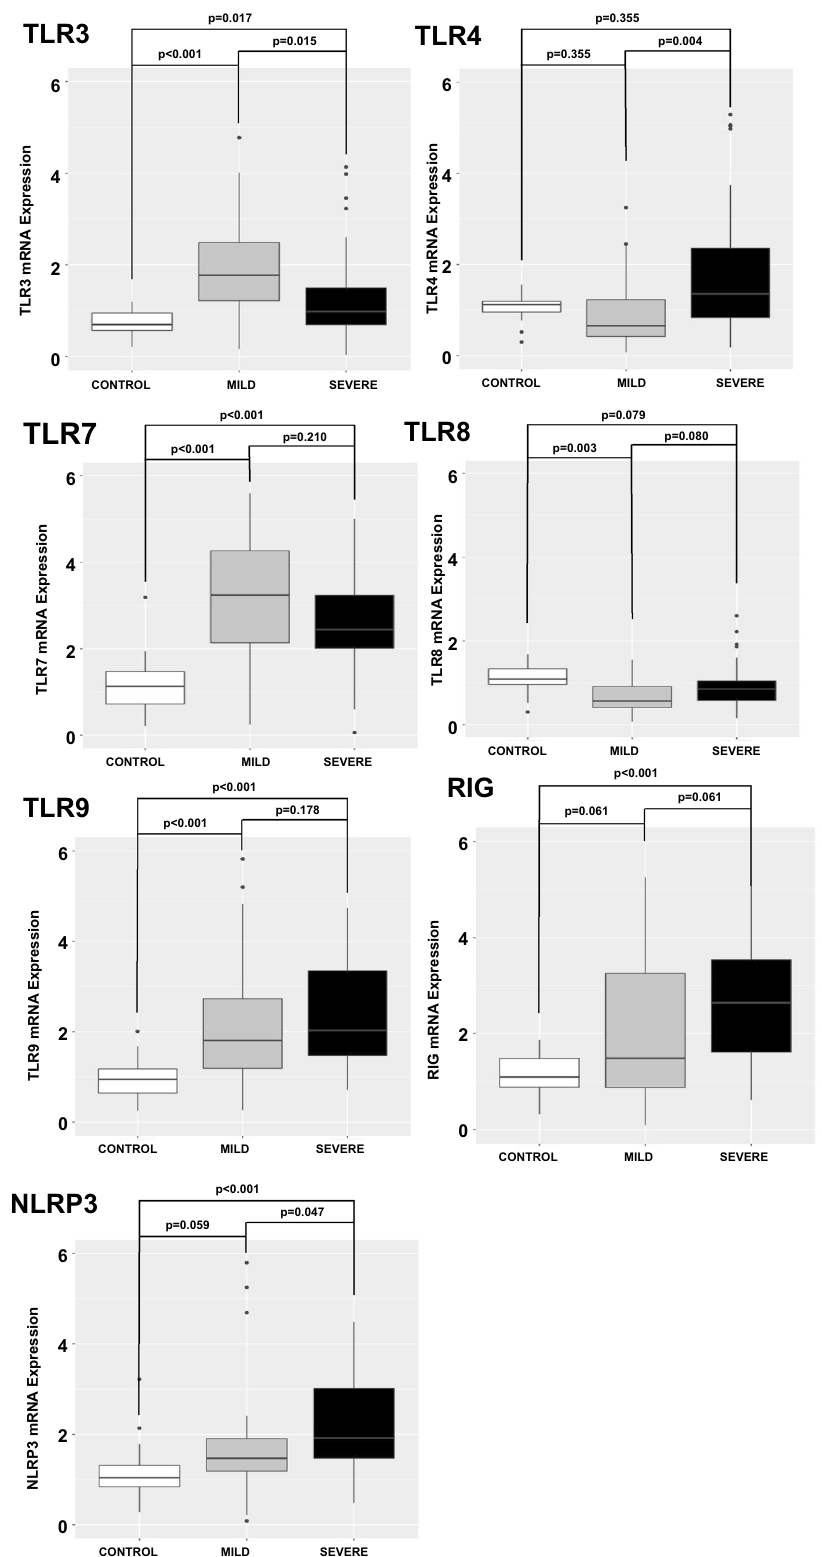
Figure 1. Quantitative mRNA of Pattern Recognition Receptors (PRRs) in circulating leukocytes of patients with COVID-19 on admission day. Expression of PRRs (mRNA) was measured in circulating leukocytes. Compared to the CONTROL group (N = 17 patients), increased mRNA transcription was observed for TLRs 3, 7, 9, RIGI, and NLRP3 in COVID-19 patients, while TLR8 was decreased. No significant difference in mRNA transcription for TLRs 7, 8 and 9, RIG, or NLRP3 was observed between COVID-19 MILD (N = 29 patients) and COVID-19 SEVERE (N = 50 patients) groups. On the other hand, TLR3 mRNA was decreased, while TLR4 mRNA was increased in COVID- 19 SEVERE group when compared to COVID-19 MILD group. P values were calculated using the nonparametric Kruskal–Wallis test in R software (version 4.0.3 for